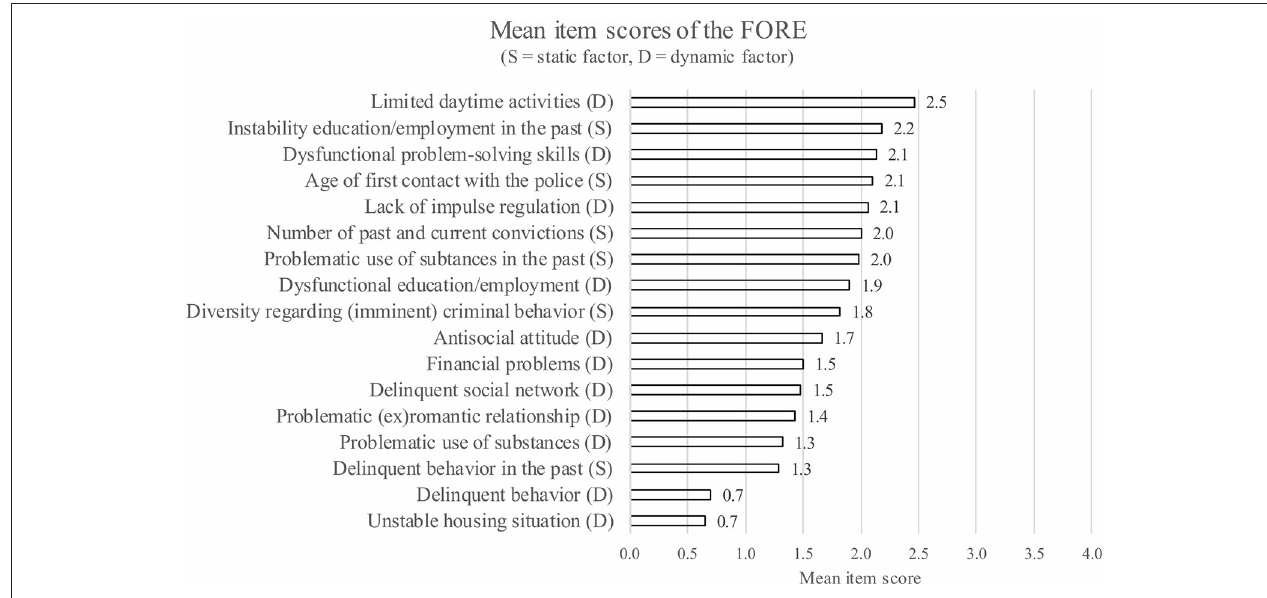
FIGURE 2 | The average item scores of the ForFACT patients on the FORE ( n = 111).